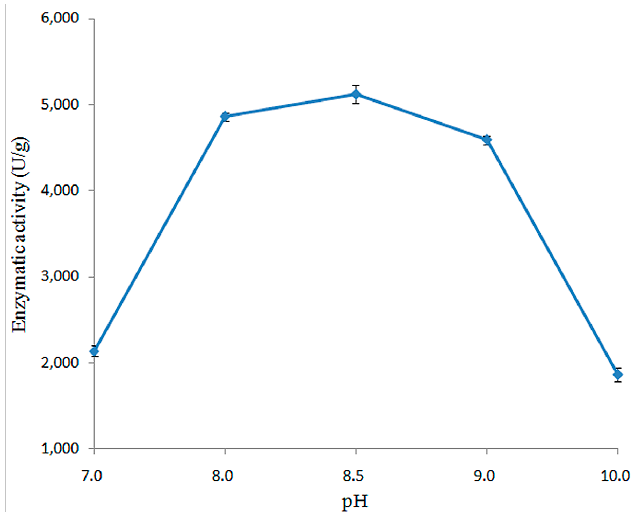
Figure 5. Effect of pH on activity of the purified pfGDPD. Enzymatic activities were measured under various pH buffers under standard assay conditions with BpNPP as substrate.